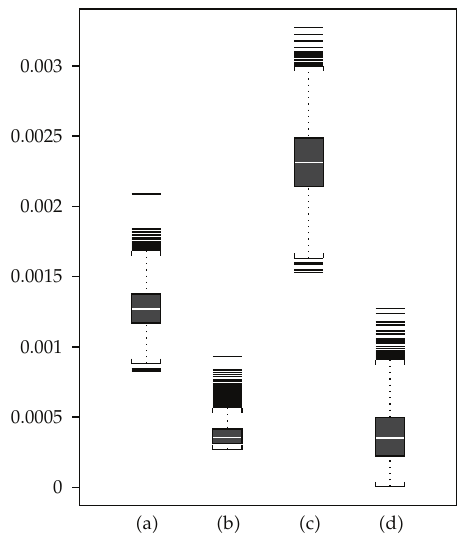
Figure 11: Example 5.3: Boxplots of the 5000 RMSE-values using estimators with the Haar wavelet, for linear estimates (cid:5) a (cid:6)